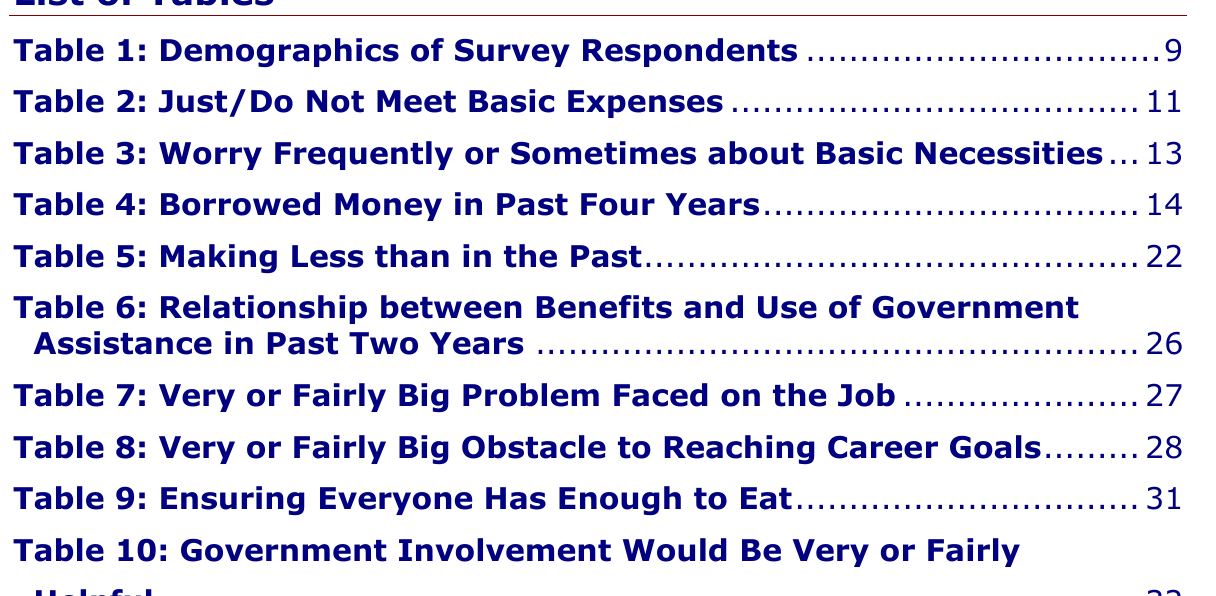
Table 8: Very or Fairly Big Obstacle to Reaching Career Goals ......... 28 Table 10: Government Involvement Would Be Very or